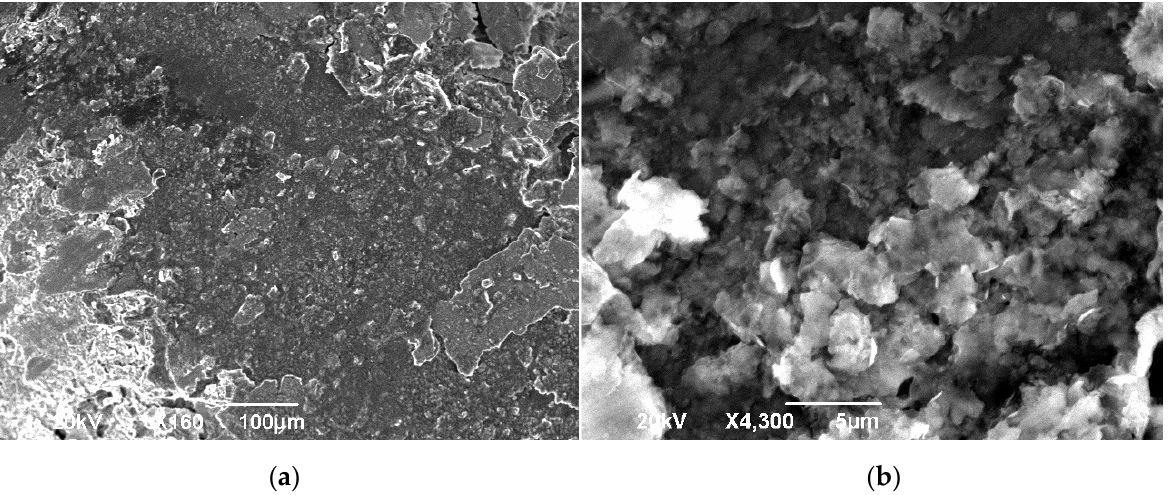
Figure 8. ( a ) SEM view of grease located in the tool tip. ( b ) Detail of Cu-Ni particles.